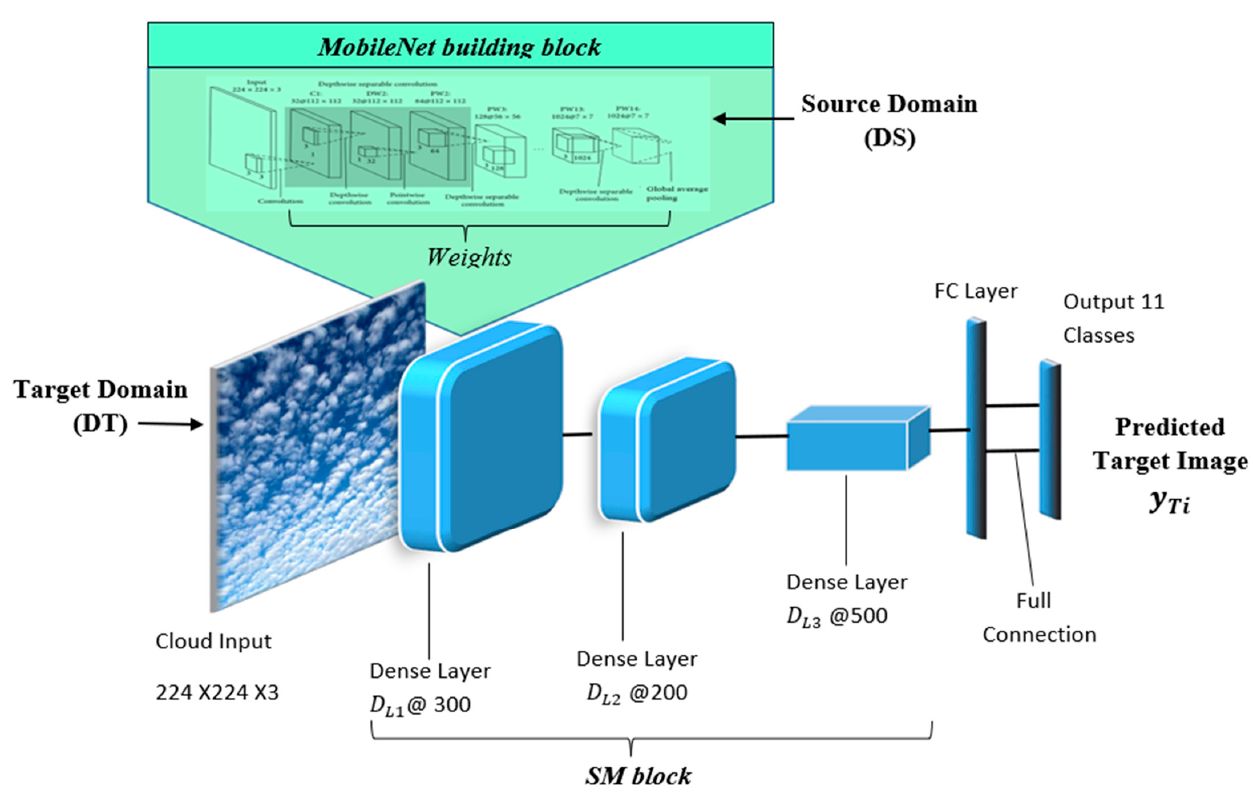
Figure 1. Cloud-MobiNet architecture. Figure 2 is the diagram of the MobileNet building block inside Cloud-Mobinet architecture.